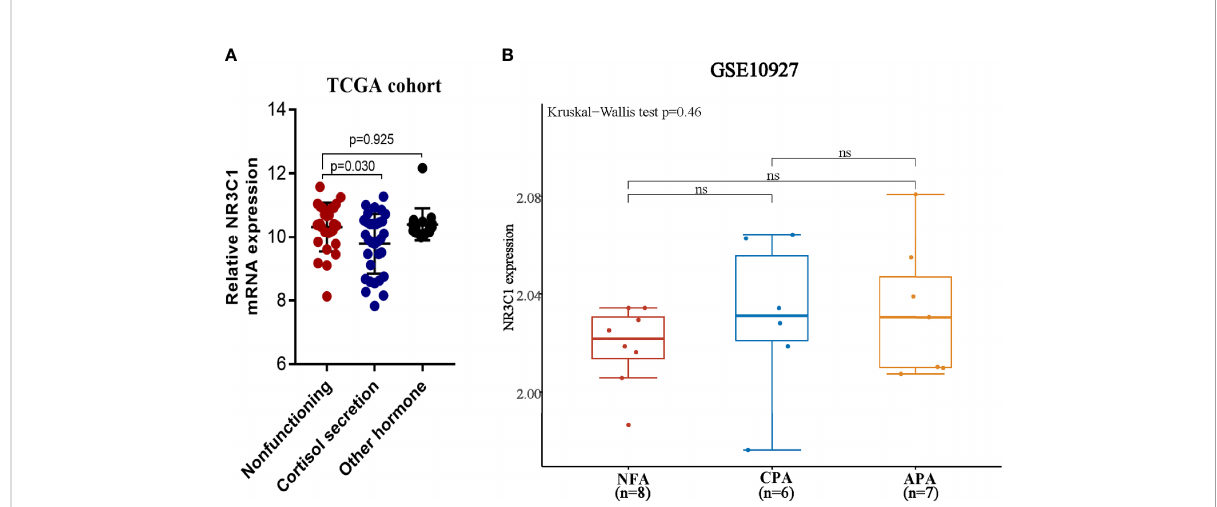
FIGURE 2 The mRNA expression of GR in the ACC and adrenal adenoma. (A) Relative mRNA expression of GR in the nonfunctioning tumors, cortisol- secreting ACC and other hormone-secreting ACC. (B) Relative mRNA expression of GR in nonfunctional adenoma (NFA), cortisol-producing adenoma (CPA) and aldosterone-producing adenoma (APA). ns, no signi fi